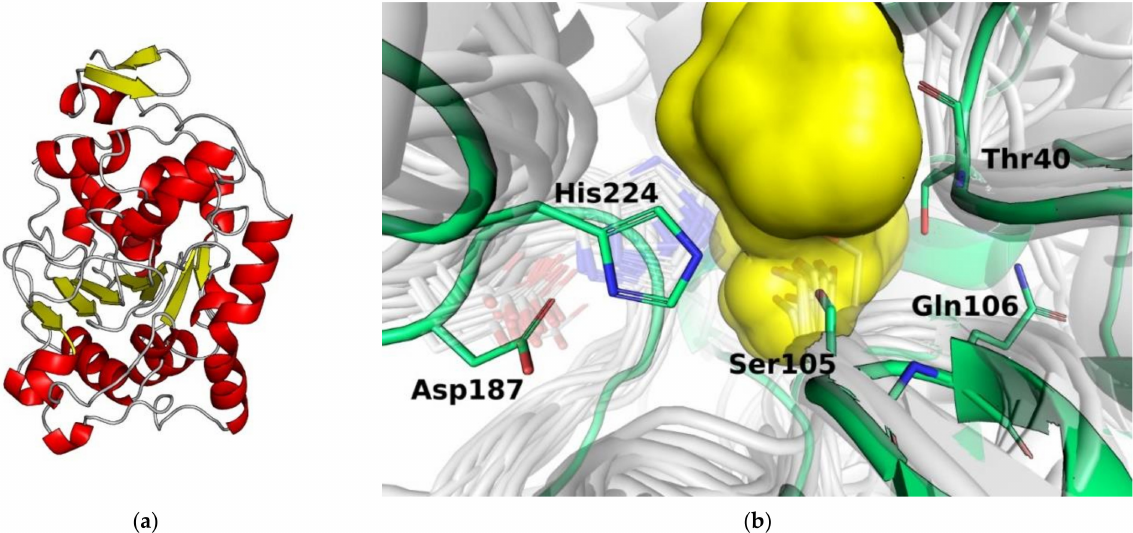
Figure 6. ( a ) Structure of the α / β -hydrolase motif of lipase B from Candida antarctica ; ( b ) Candida antarctica lipase B active site (bold lines) compared to α / β -hydrolase family enzymes, including lipases and proteases (transparent lines). The view is taken from the inner side of catalytic amino acid residues shown by sticks; substrate-binding pocket of lipase B from Candida antarctica is shown by yellow surface. The figure was prepared using PyMol based on the crystal structure PDB ID: